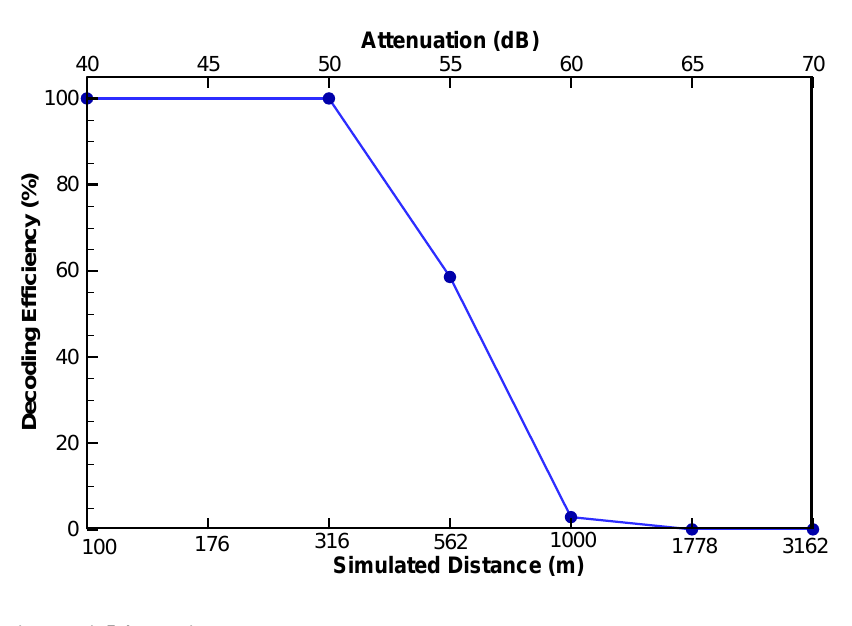
Figure 8. Decoding efficiency of a JSATS cabled hydrophone in an ideal